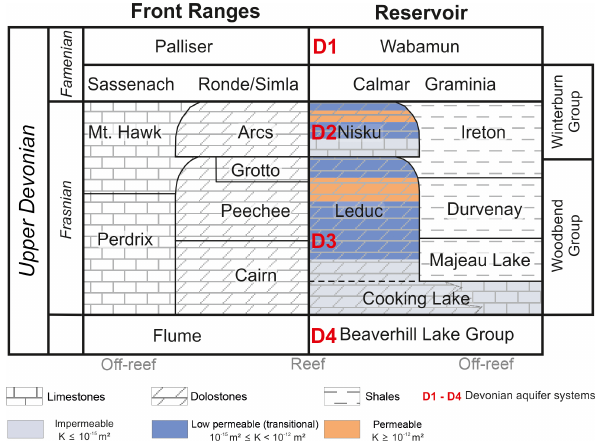
Figure 3. Simplified lithostratigraphy for the Alberta Basin and the adjacent Rocky Mountains, and a schematic classification of per- meability zones (based on Switzer et al., 1994).